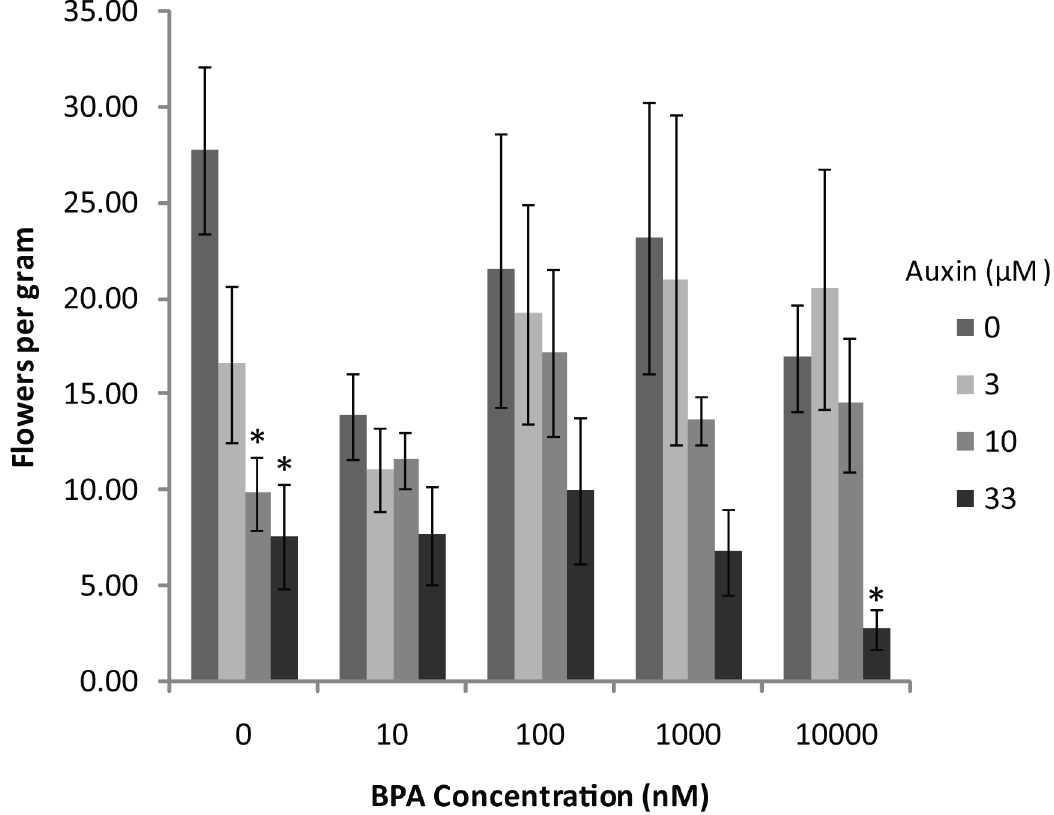
Fig 5. The effect of auxin on plant flowering with and without BPA. Auxin disrupted flowering in A . thaliana as shown in the 0nM BPA data. The decrease in flowering is not significant when BPA is present except at 10 μ M BPA and 33 μ M auxin. Bars represent the average of four jars of plants grown on agar containing BPA and auxin at each concentration. Error bars represent standard error. * indicates p-value < 0.05 when compared to 0 μ M auxin treatment at that BPA